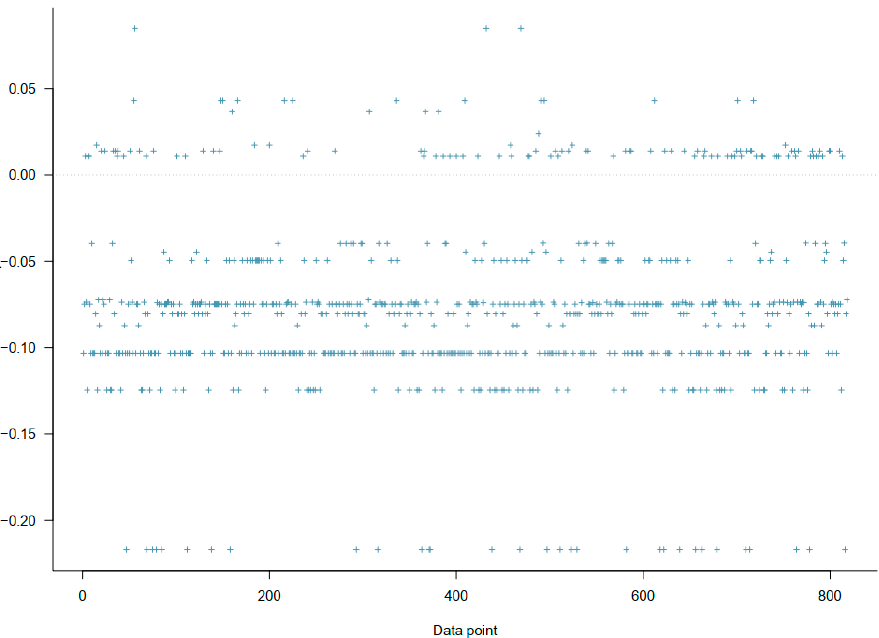
Figure 5. Model 2 ′ s trace plots. Table 3. Model 2 ′ s simulated posteriors. Parameter